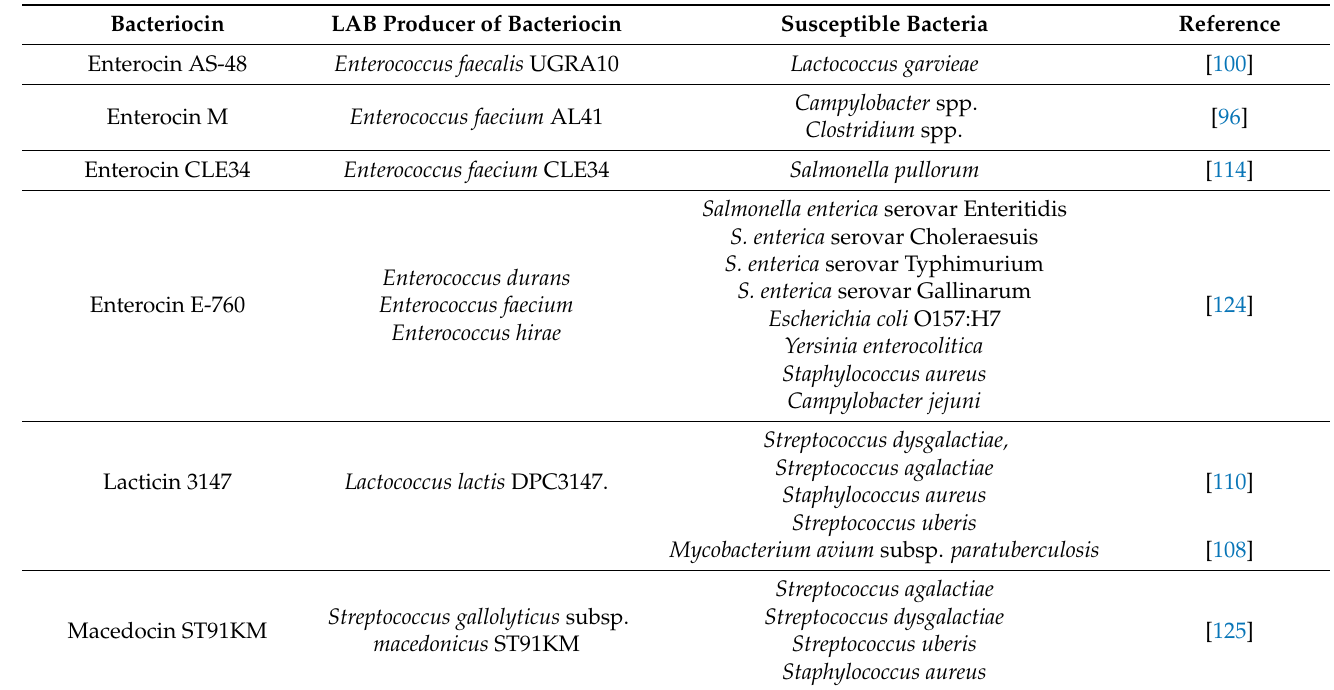
Table 2. Bacteriocins produced by lactic acid bacteria inhibit bacteria of interest in veterinary medicine.